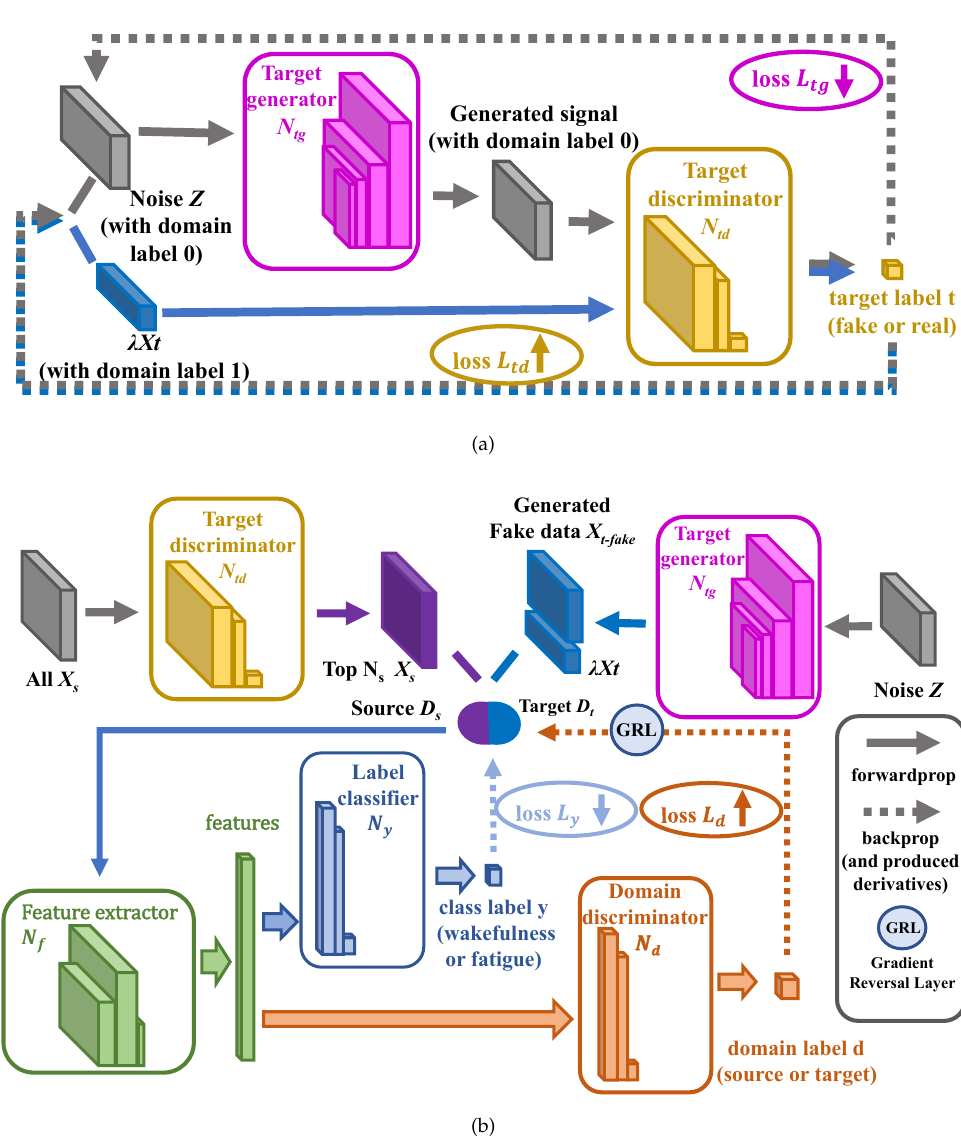
Figure 5. The Training Process of Generative-DANN (GDANN). (( a ) is the process of training GAN with minimizing N tg and maximizing N td , and ( b ) is the process of trainging DANN with minimizing N f , N y and maximizing N d , which contains the process of screening the top N s source domain subjects’ data that are most similar to the target domain and use random noise to train the domain alignment model